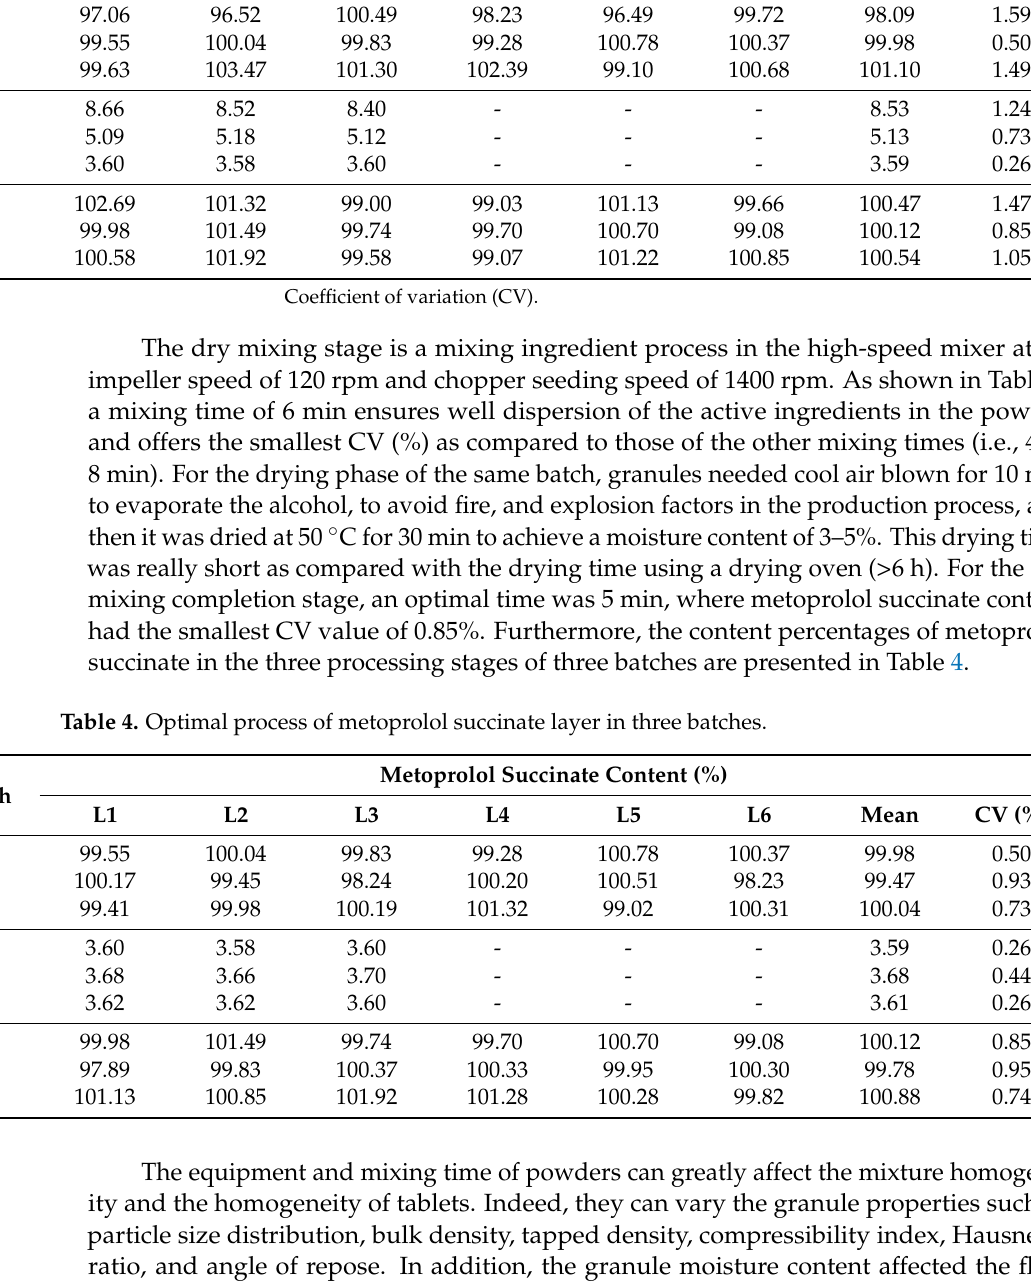
Table 3. Processing time during dry mixing-, drying stages of metoprolol succinate layer at different locations (L) in batch 1. Stage